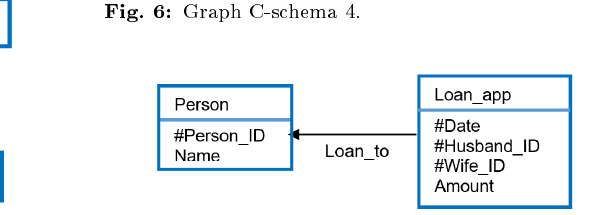
Fig. 6: Graph C-schema 4.